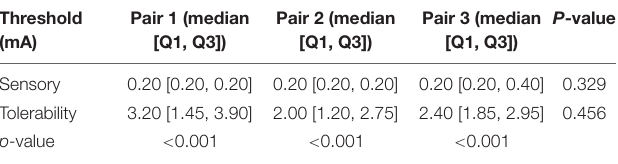
TABLE 4 | The statistical sensory and tolerability threshold results of the electroacupuncture (EA’s) electrode